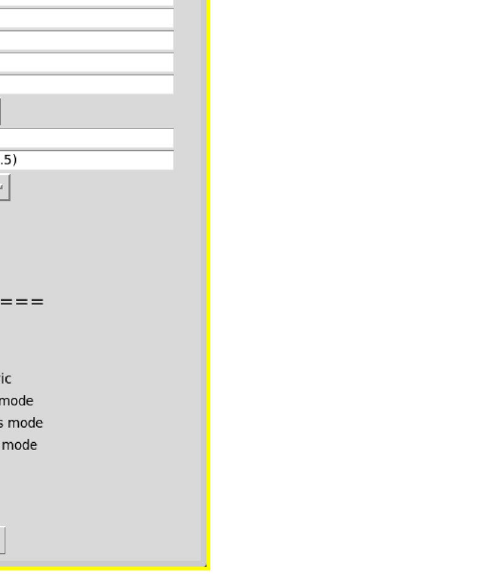
Figure 2. ViReflow Graphical User Interface